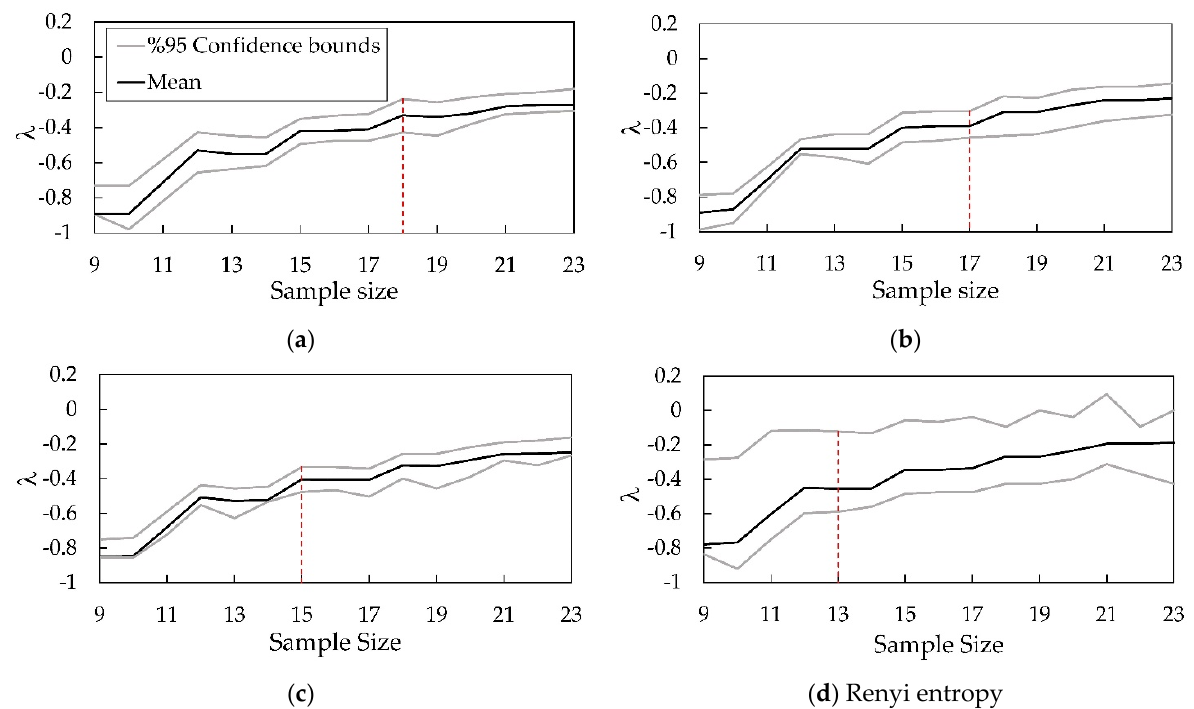
Figure 4. Changes in transfer factor ( λ ) values in different sample sizes (SSs) for all entropy models. ( a ) Tsallis entropy, ( b ) Shannon entropy, ( c ) Shannon PL entropy, and ( d ) Renyi entropy.